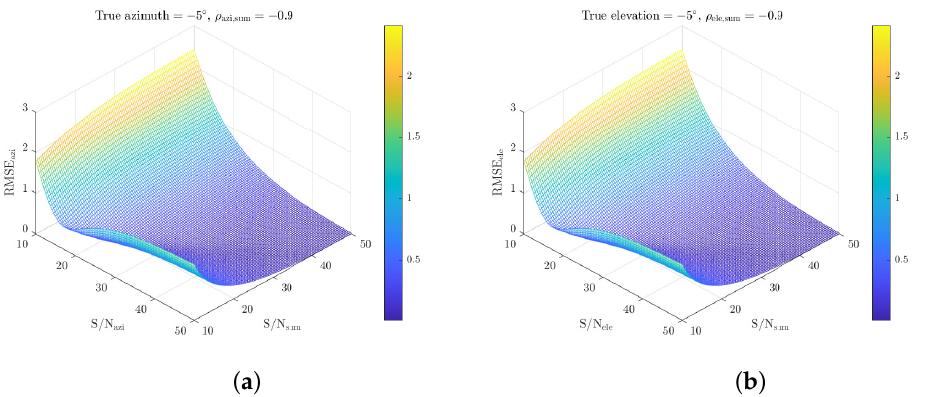
Figure 13. RMSE for difference channel SNR and sum channel SNR ( θ azi , θ ele = − 5 ◦ , ρ azi,sum = − 0.9).